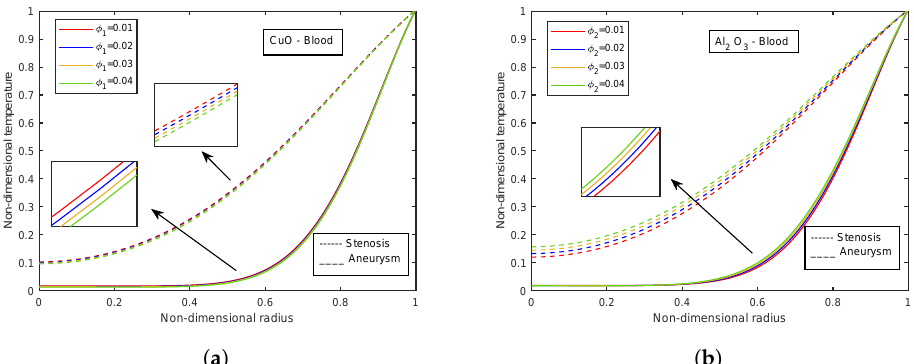
Figure 23. Influence of volume fraction of ( a ) CuO-nanoparticles, ( b ) Al 2 O 3 -nanoparticles on temper- ature profiles.